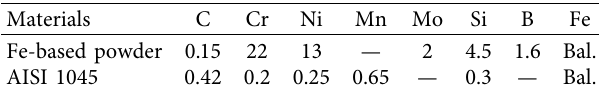
Table 1: Chemical composition of AISI 1045 and Fe-based powder